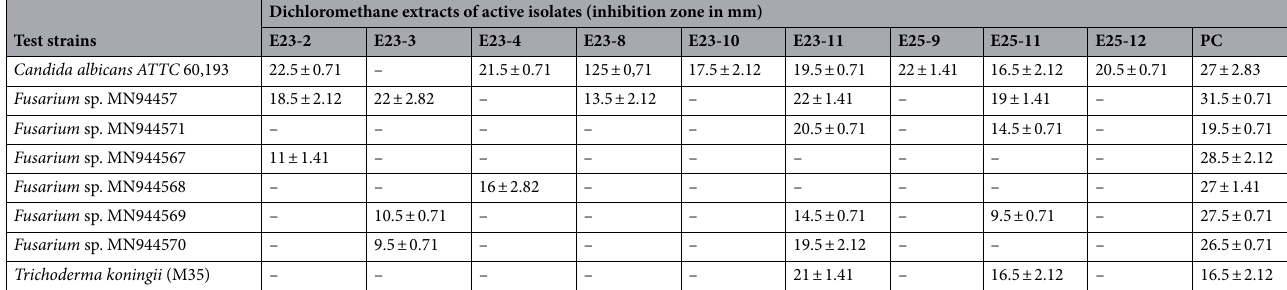
Table 4. Secondary screening (antifungal activity) by disc diffusion method. (–) no inhibition zone, PC positive control (Cycloheximide) and disc diameter = 6